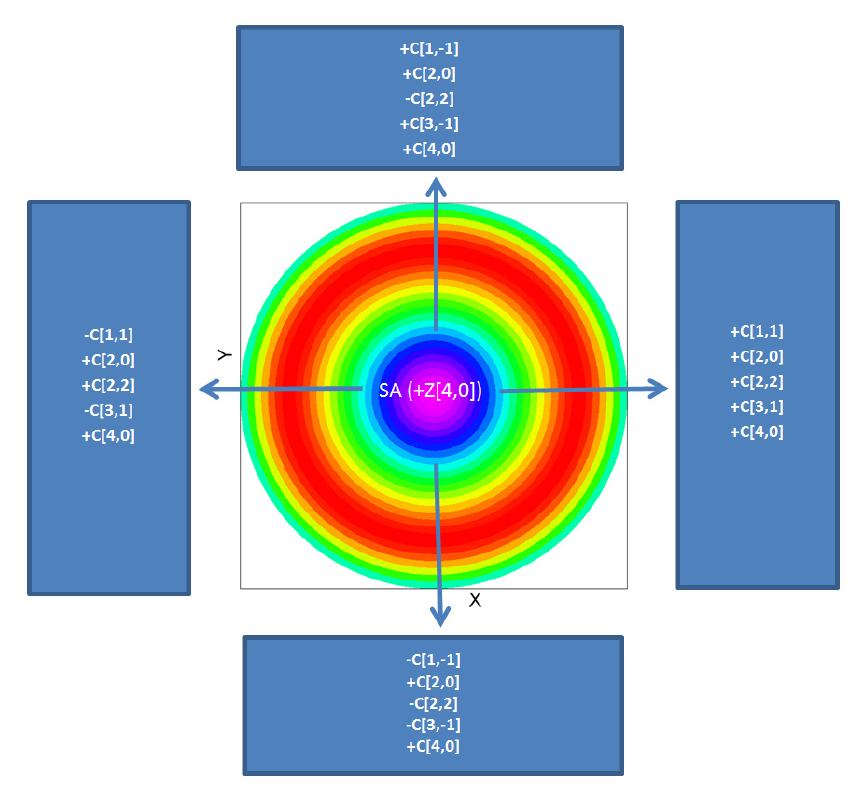
Figure 3. Effect of translation in spherical aberration (SA) (C[4,0]) in positive and negative direction in the orthogonal principal axes. Notice that translation in the horizontal axis results in induction of horizontal tilt (C[1,1]) and horizontal coma (C[3,1]), while translation in the vertical axis results in the induction of vertical tilt (C[1, − 1]) and vertical coma (C[3, − 1]). Astigmatism and SA remain unaffected from the axis of translation. In addition, in the horizontal axis, the direction of translation effects the sign of the induced horizontal tilt (C[1,1]) and horizontal coma (C[3,1]); while in the vertical axis, the direction of translation effects the sign of the induced vertical tilt (C[1, − 1]) and vertical coma (C[3, − 1]).